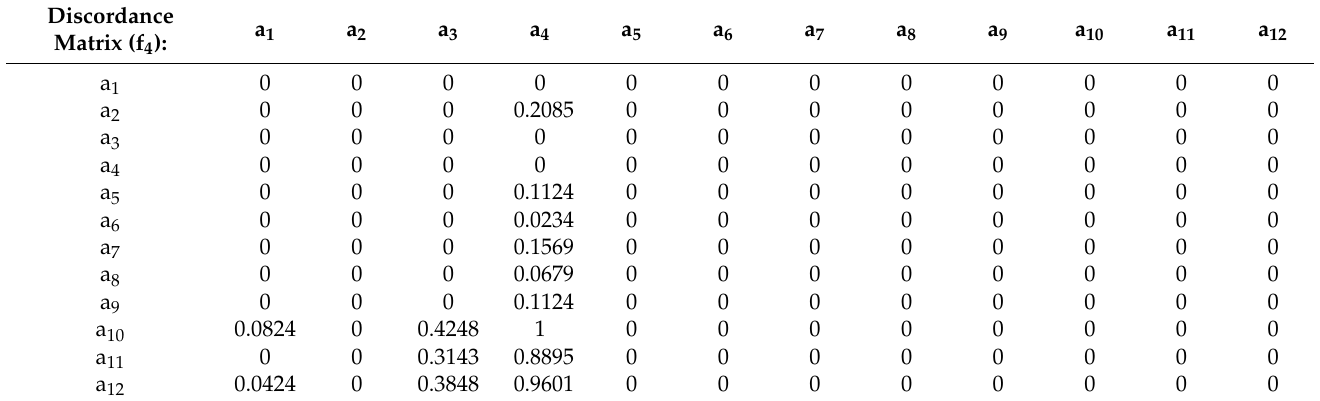
Table A4. Values of the non-compliance indicators according to the 4th criterion.